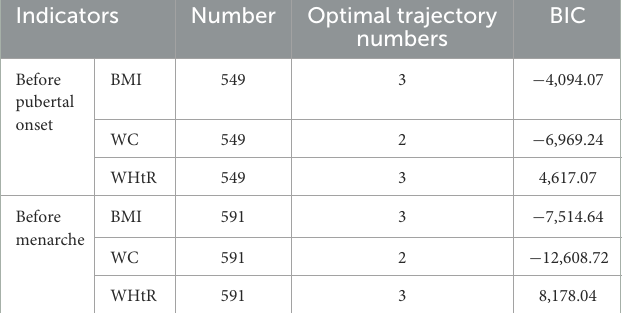
TABLE 2 The model fitting of obesity indicators before pubertal onset and menarche in girls.